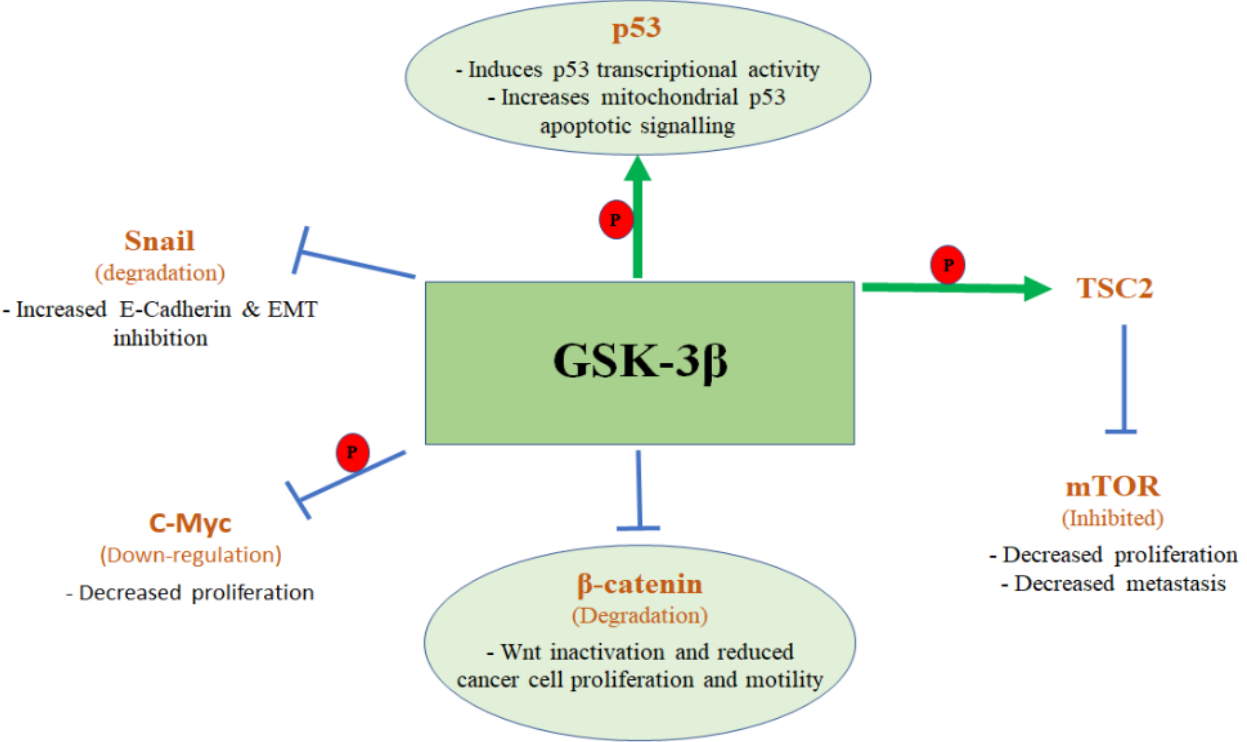
Figure 2. Proposed onco-suppressive pathways regulated by GSK-3 β but found not relevant to pancreatic cancer.